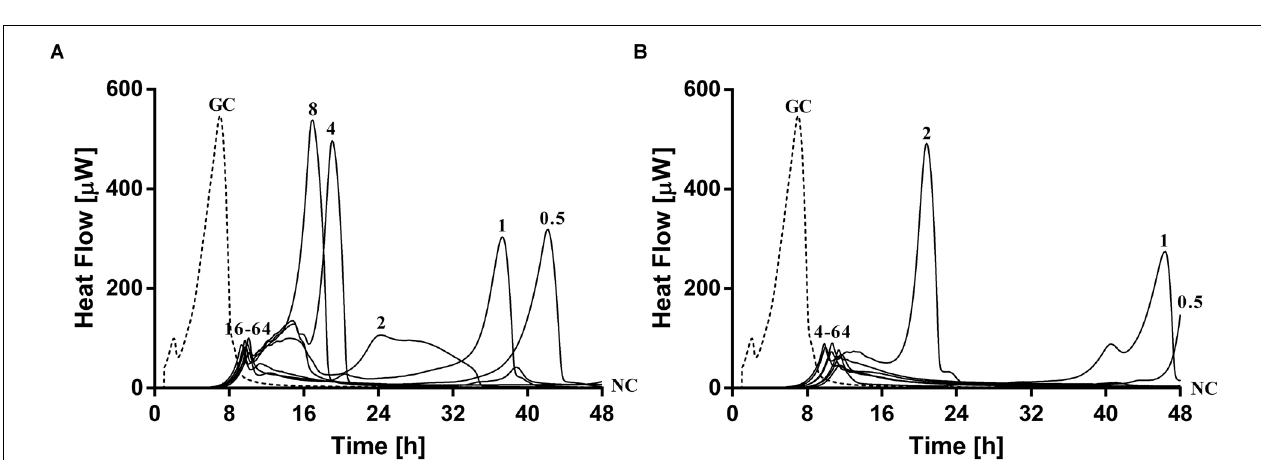
FIGURE 6 | Evaluation of MRSA ATCC 43300/ P. aeruginosa ATCC 27853 dual-species biofilm viability after simultaneous exposure during 24 h to ciprofloxacin at increasing doses (0.5–64 mg/L) plus (A) PYO or (B) PYO+Sb-1 monitored by microcalorimetry. Numbers represent antibiotic concentrations (in mg/L). GC, growth control (dashed line); NC, negative